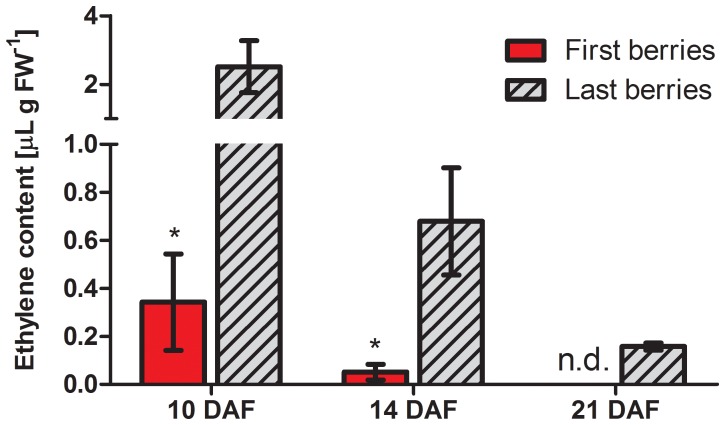
Ethylene content in “first berries” compared to “last berries” during and after the abscission period.Ethylene content in “first berries” and “last berries” measured at 10, 14 and 21 DAF. Asterisk indicates that differences are significant between “first berries” and “last berries”. n.d., not detected. Significance was assessed using p value <0.05 (n = 3). Error bars are STERR±.